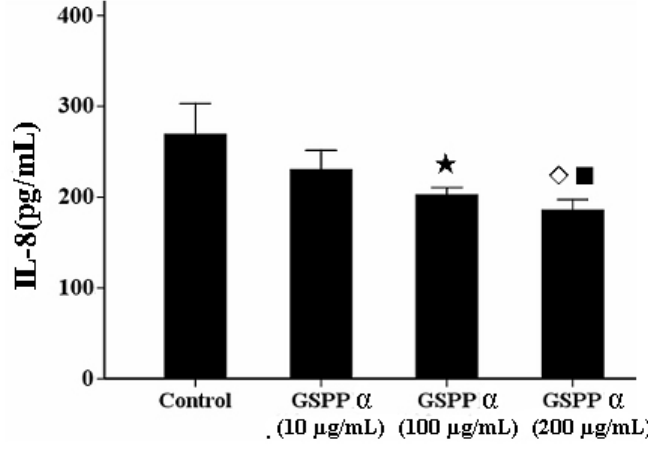
Figure 6. Effect of Gekko sulfated glycopeptides on IL-8 secretion. The values represent means ± SD. P = 0.006. ★ versus control group, P = 0.005; ◇ versus control group, P = 0.001; ■ versus 10 µg/mL GSPP α , P = 0.032. GSPP α : Gekko sulfated